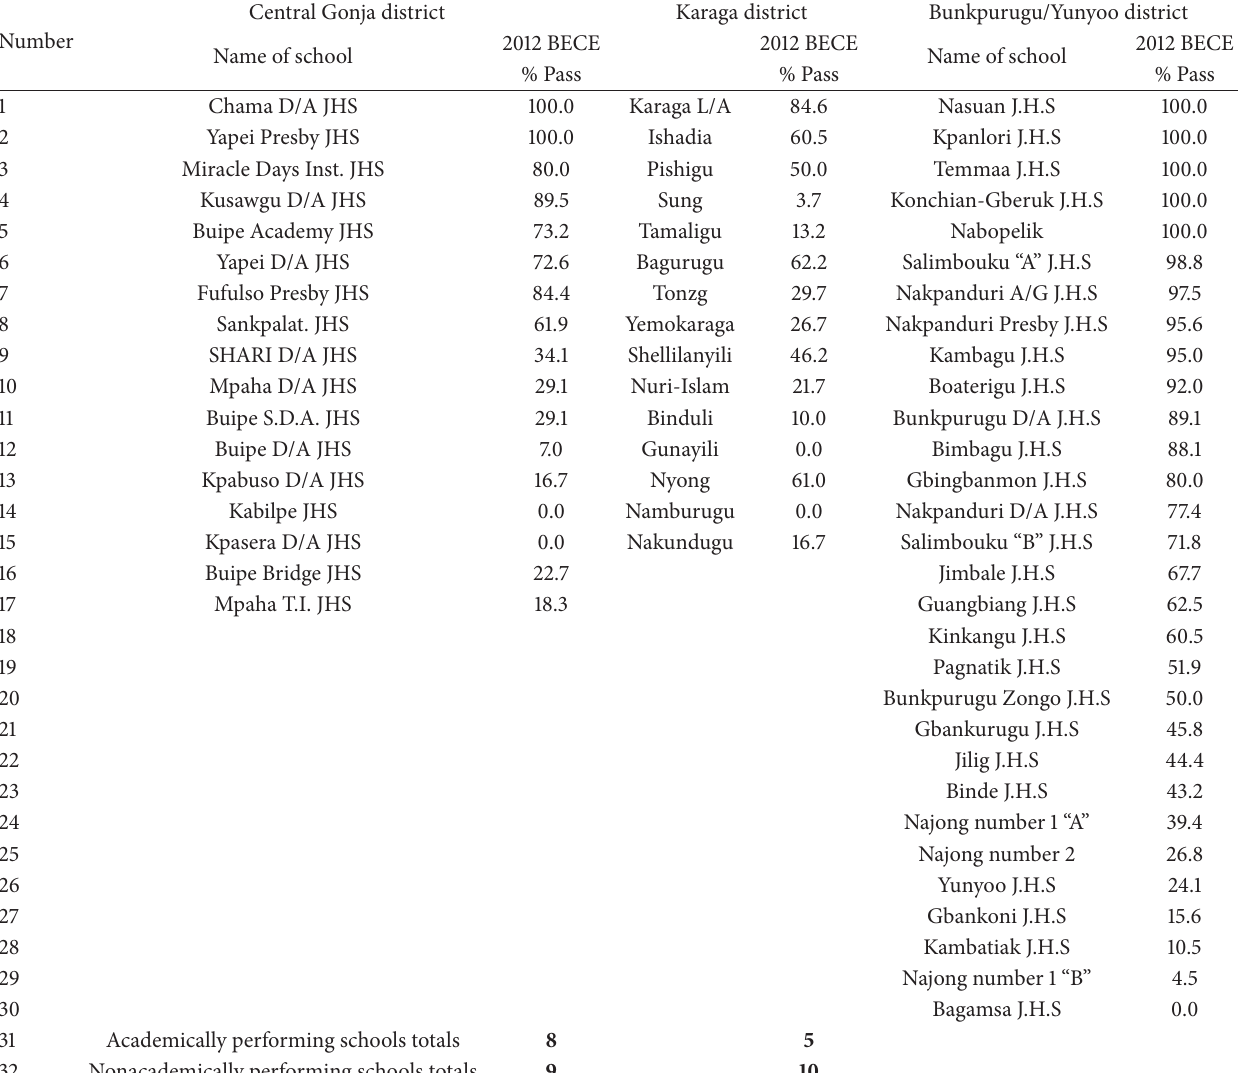
Table 1: Performance of Basic Schools in 2012 BECE in some Selected Districts in Northern Region of Ghana.